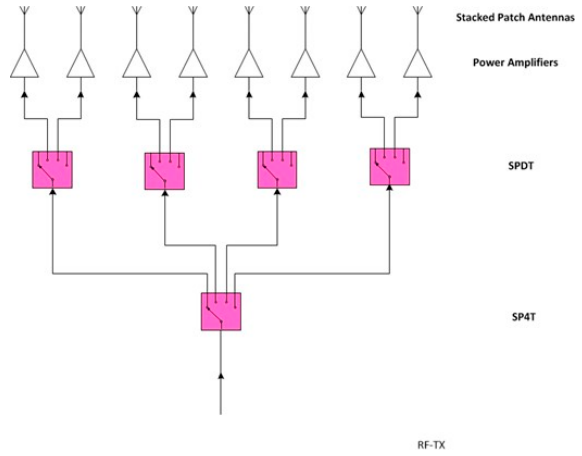
Figure 7. Transmitting antenna module block diagram.